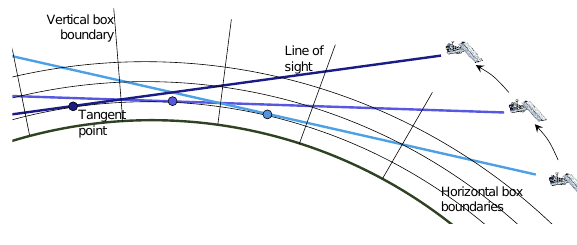
Fig. 2. Definition of the horizontal model space for the 2-D retrieval with respect to the tangent points of the scanning sequences. For illustration purposes, the LOS of only one measurement (for the same TH) per scanning sequence is shown.